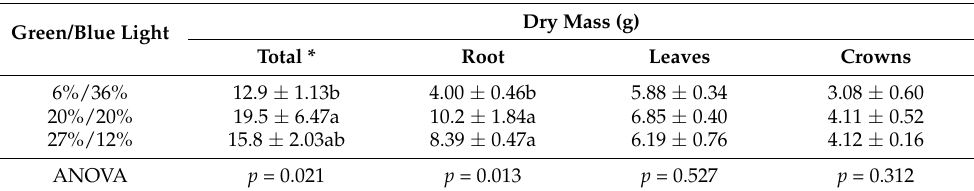
Figure 4. Effect of the green (500–600 nm) and blue (400–500 nm) light balance on total fresh mass of strawberry plants grown in an indoor vertical system with LED lighting. Bars represent the standard error of the mean. Columns with different letters indicate significant differences according to Duncan’s multiple comparison test with p < 0.05. Table 3. Effect of the green (500–600 nm) and blue (400–500 nm) light balance on the dry mass of strawberry plants grown in an indoor vertical system with LED lighting.